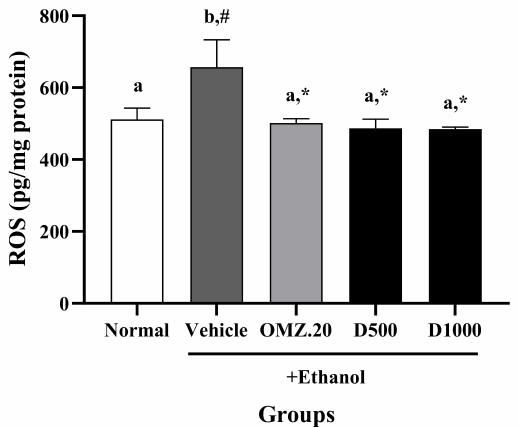
Figure 4. Effects of OMZ and Phy-Blica-D on the ROS levels in the stomachs of rats exposed to ethanol. Data are expressed as the mean ± SEM ( n = 6 per group) and were analyzed using one-way ANOVA and Duncan’s post hoc multiple-comparison test. * Significantly different from the vehicle control at p < 0.05. # Significantly different from the normal group at p < 0.05. Different letters ( a,b ) indicate significant differences ( p < 0.05) between treatments determined by Duncan’s multiple-range test.